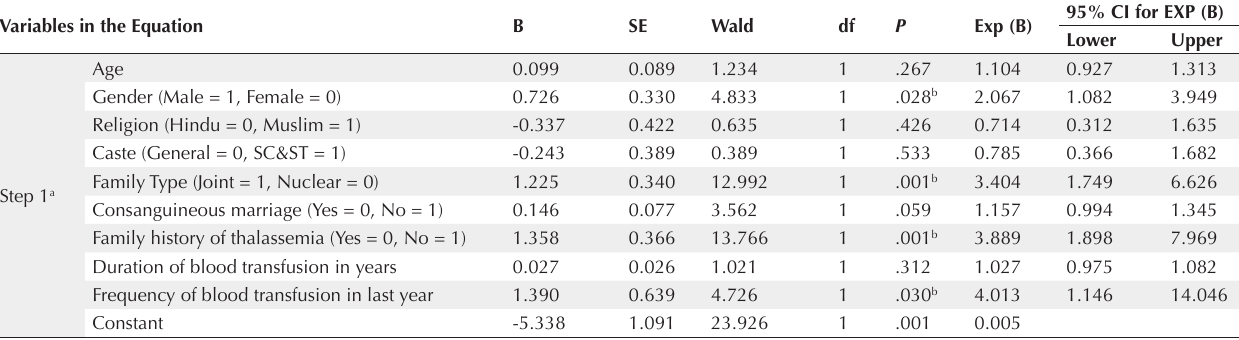
Table 4. Logistic Regression Model for the Predictors of Worse School Activity of Thalassemic Children Variables in the